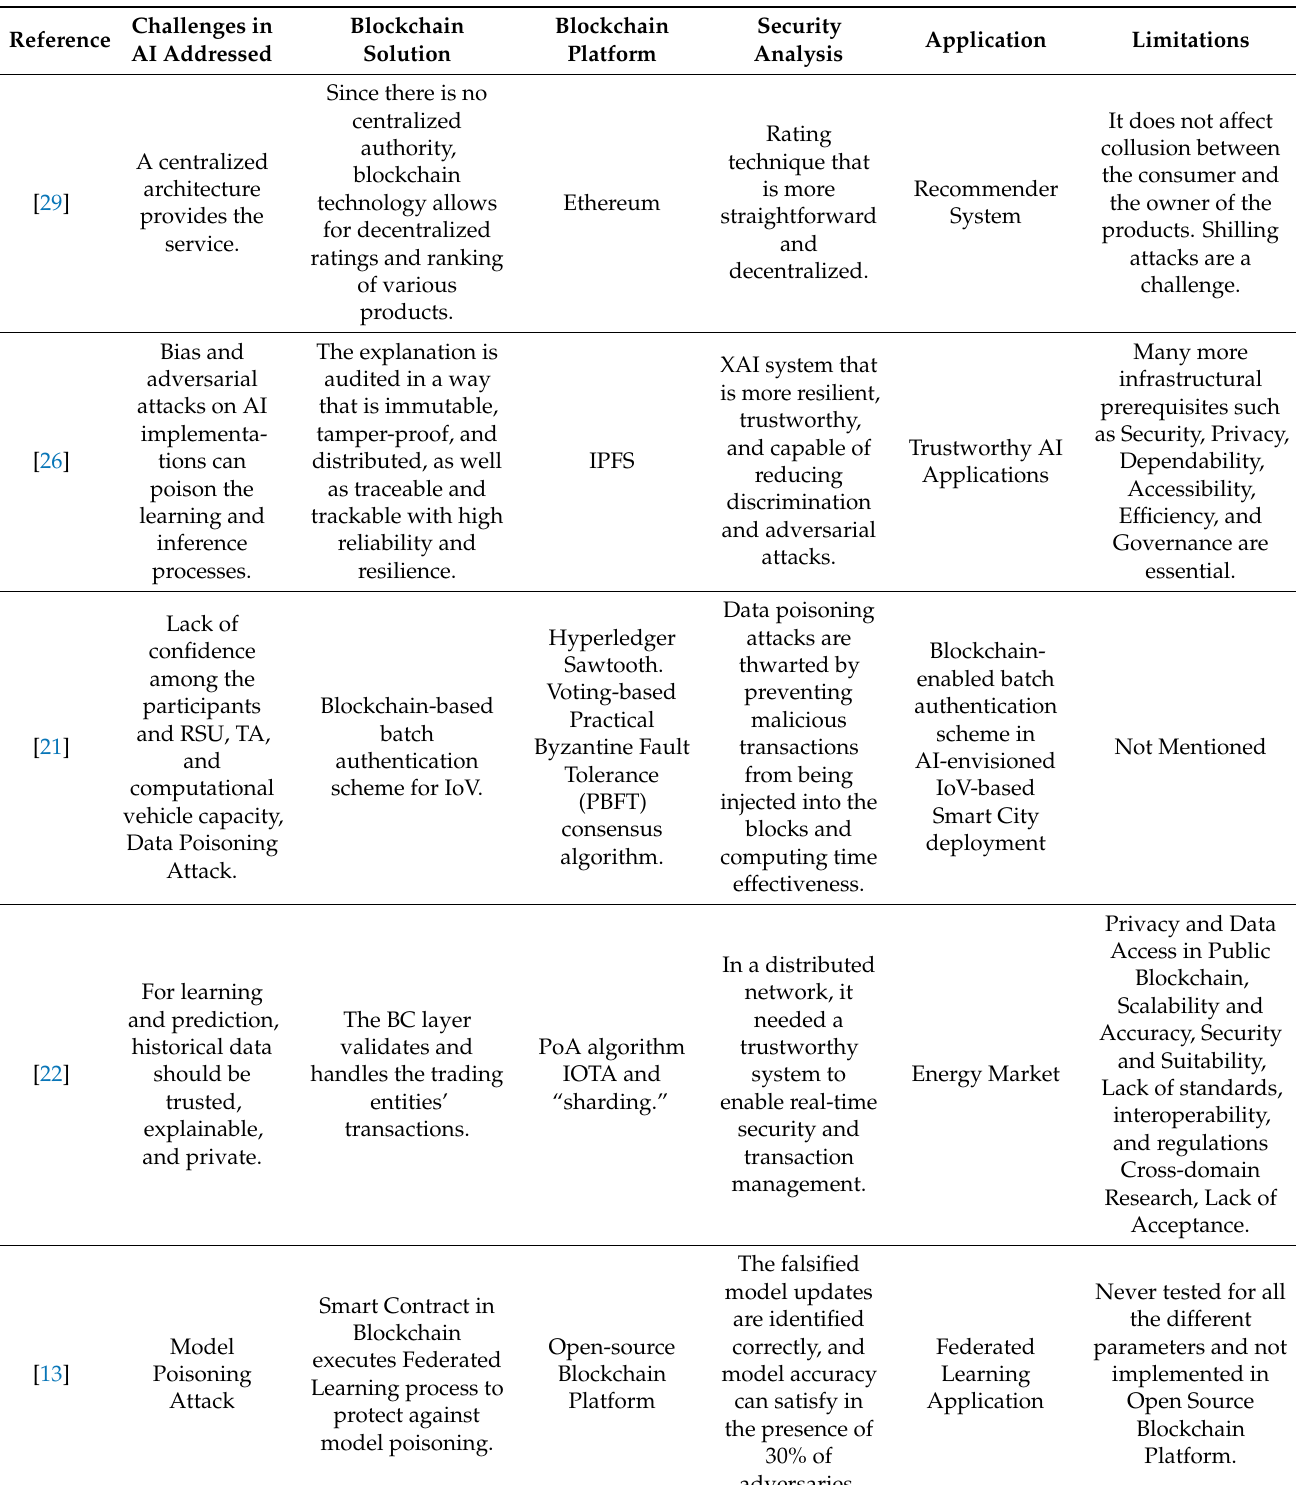
Table 18 highlights the challenges in AI, Blockchain solution for the same, Blockchain platform used, security analysis, and application in the selected papers. The AI applications can take benefit of Blockchain features such as immutability, transparency, privacy, trust, and security, as illustrated in Figure 20. Table 18. Blockchain solution for challenges in